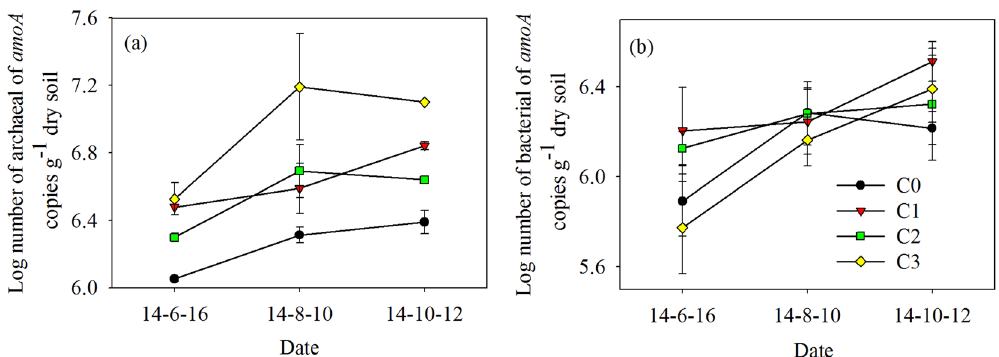
Figure 4. Variation of AOA ( a ) and AOB ( b ) amoA gene copy numbers and arithmetic mean under the four experimental treatments. Data are shown as means with standard